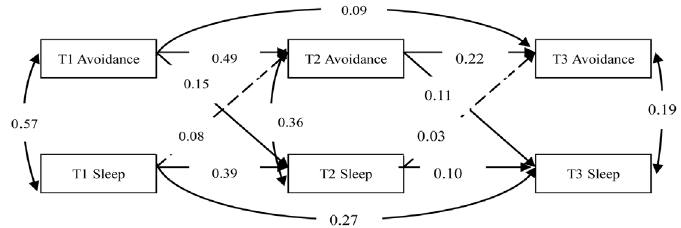
Figure 2. The model for the evaluation of the relationship between avoidance symptoms and sleep problems after controlling the other two symptom clusters of PTSD (Model 2). Dashed lines indicate insignificant paths. Avoidance symptoms=Avoidance, Sleep problems=Sleep.